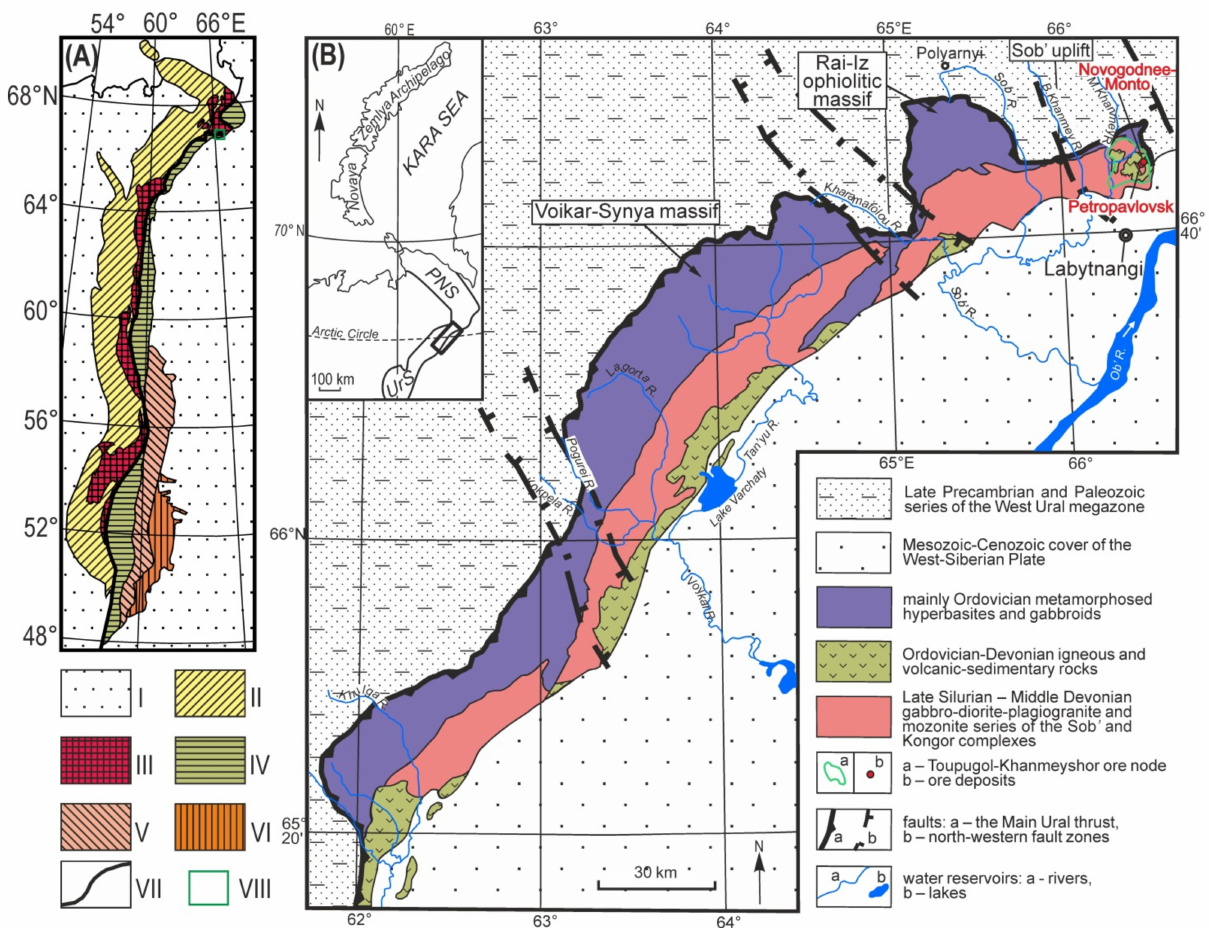
Figure 1. Location maps. ( A ) Tectonic scheme of the Ural fold belt based on the geological map in [42]; I—Mesozoic– Cenozoic complexes of the East European platform and West Siberian plate; II, III—Paleozoic complexes of the Western Urals (II) and Precambrian (III); IV—Early–Middle Paleozoic complexes of the Tagil-Magnitogorsk megazone; V—Precambrian and Paleozoic complexes of the East Uralian megazone; VI—Paleozoic and Precambrian complexes of the Trans-Urals; VII—Main Ural fault; VIII—position of the Toupugol-Khanmeyshor ore district of the Polar Urals. ( B ) The position of the Toupugol-Khanmeyshor ore district in the structures of the Polar Urals was compiled using data from [38,39]. PNS and UrS (on the inset)—Paykhoy-Novaya Zemlya and Ural folding-thrust